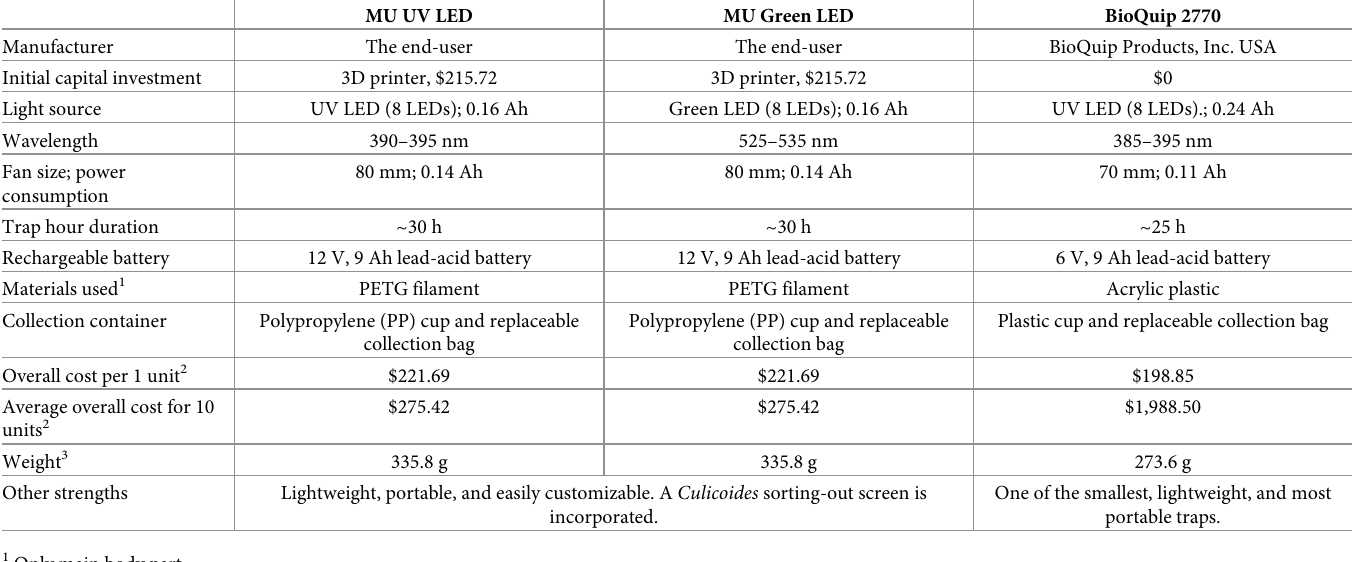
Table 2. Specifications of 3D-printed LED light traps (MU UV LED and MU Green LED) and standard UV LED light trap (BioQuip 2770) for the comparison of the efficiency for the collection of Culicoides .